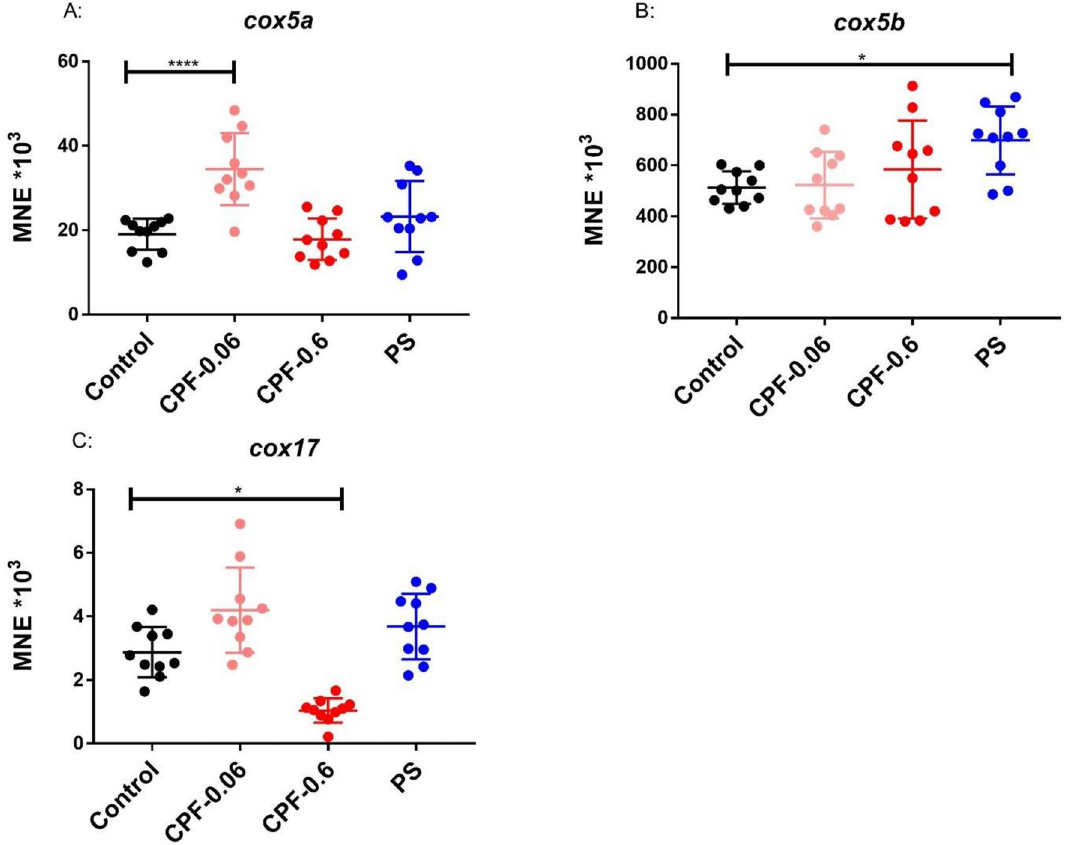
blue dots: PS, n = 10). Significant changes are marked with *.